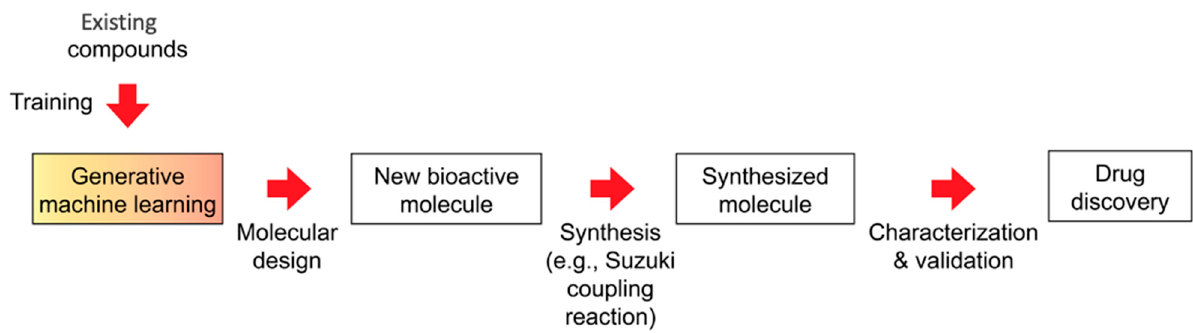
Figure 10. Concept of generative machine learning for drug discovery proposed by Merk et al. in 2018, redrawn from [90] (p. 1).